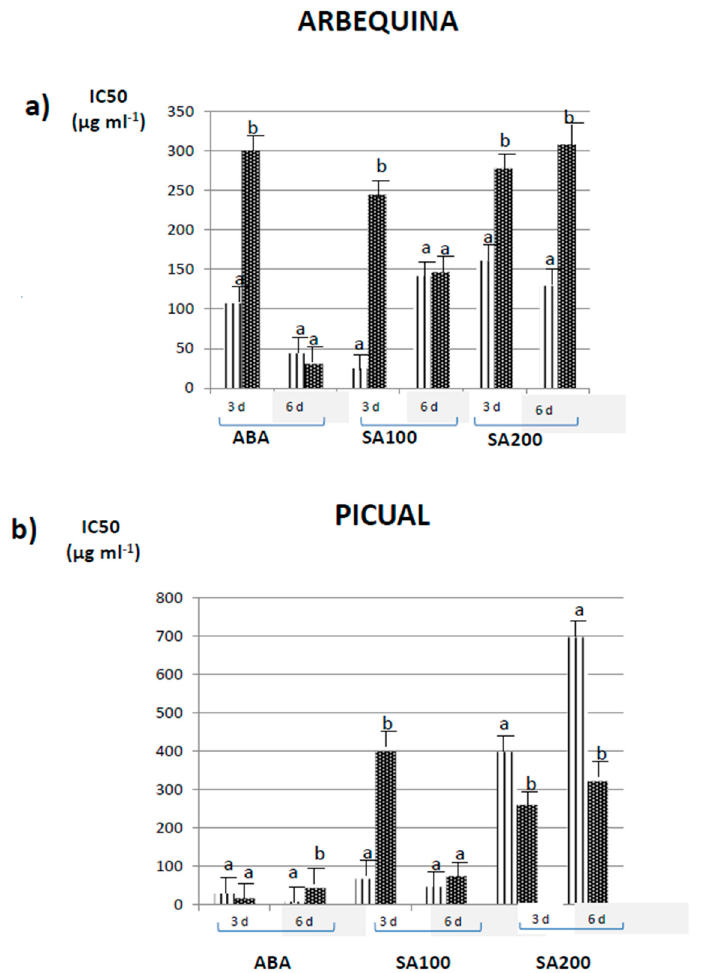
Figure 1. Free radical scavenging radical activity (expressed as IC 50 ) of olive fruits control (indicated as striped columns) and treated (indicated as black columns) with ABA, SA100 and SA200 on days 3 and 6 after treatment. Data on Arbequina ( a ) and Picual ( b ) cultivars are included. The values were estimated as means ± Standard Deviation ( n = 3). Different letters indicate significant ( p < 0.05) differences between control and treated samples.